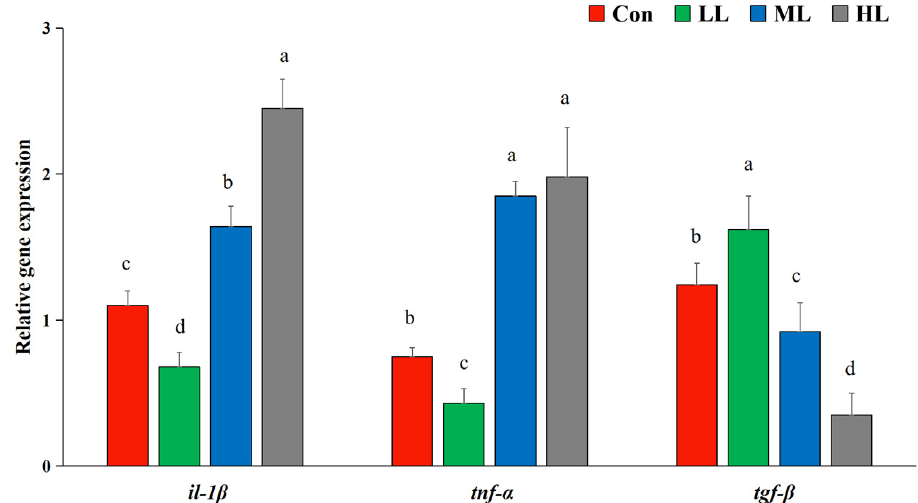
Figure 2. Effects of dietary laminarin inclusion on transcriptional expression of juvenile largemouth bass intestine. Results are expressed as mean ± SEM ( n = 3). Con means control diet. LL, ML, and HL mean 5 g Kg − 1 , 10 g Kg − 1 and 15 g Kg − 1 laminarin was supplemented into diets, respectively. Results are expressed as mean ± SEM ( n = 3). Means in the same row with different letters were significantly different among groups ( p < 0.05).